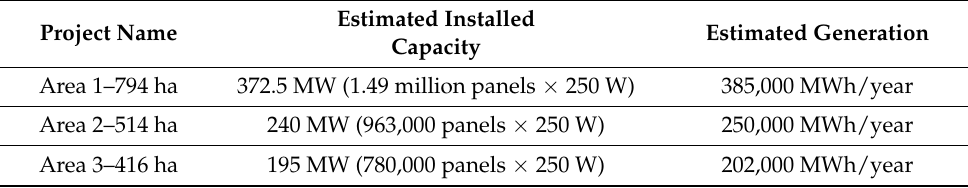
Table 10. Potential solar plants in the Nakhichevan Autonomous